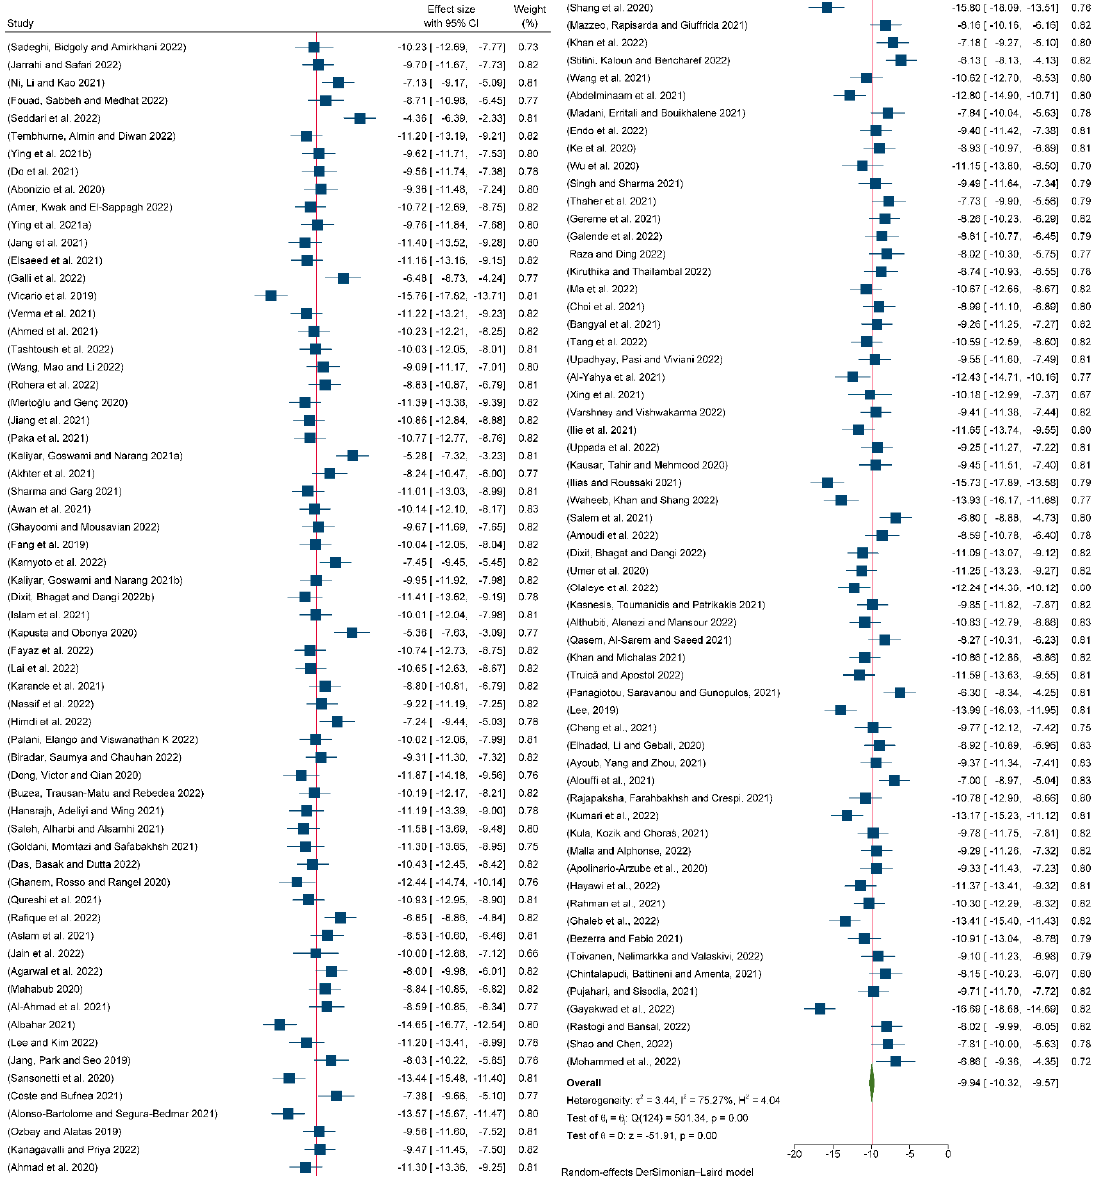
Figure 2. Forest plot for distribution of effect size of fake news detection accuracy [4,9,11–21,26,29– Figure 2. 51,62–147].